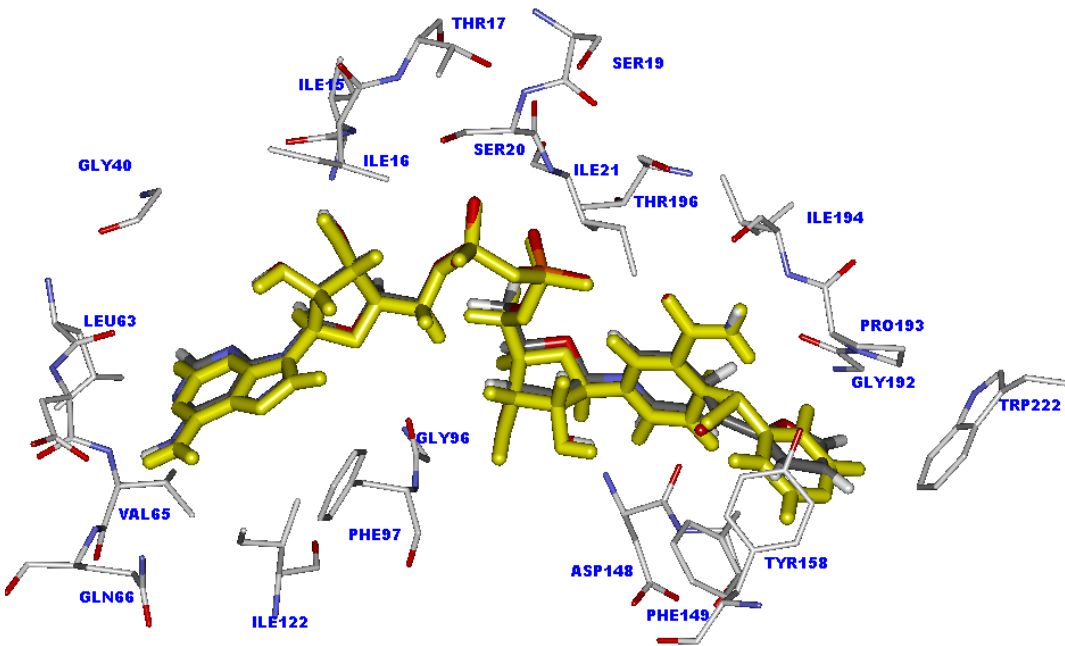
Figure 2. Superimposition of the INH-NAD adduct (colored by yellow) and compound 1 (colored by atom type) in InhA binding pocket obtained from molecular docking calculations.